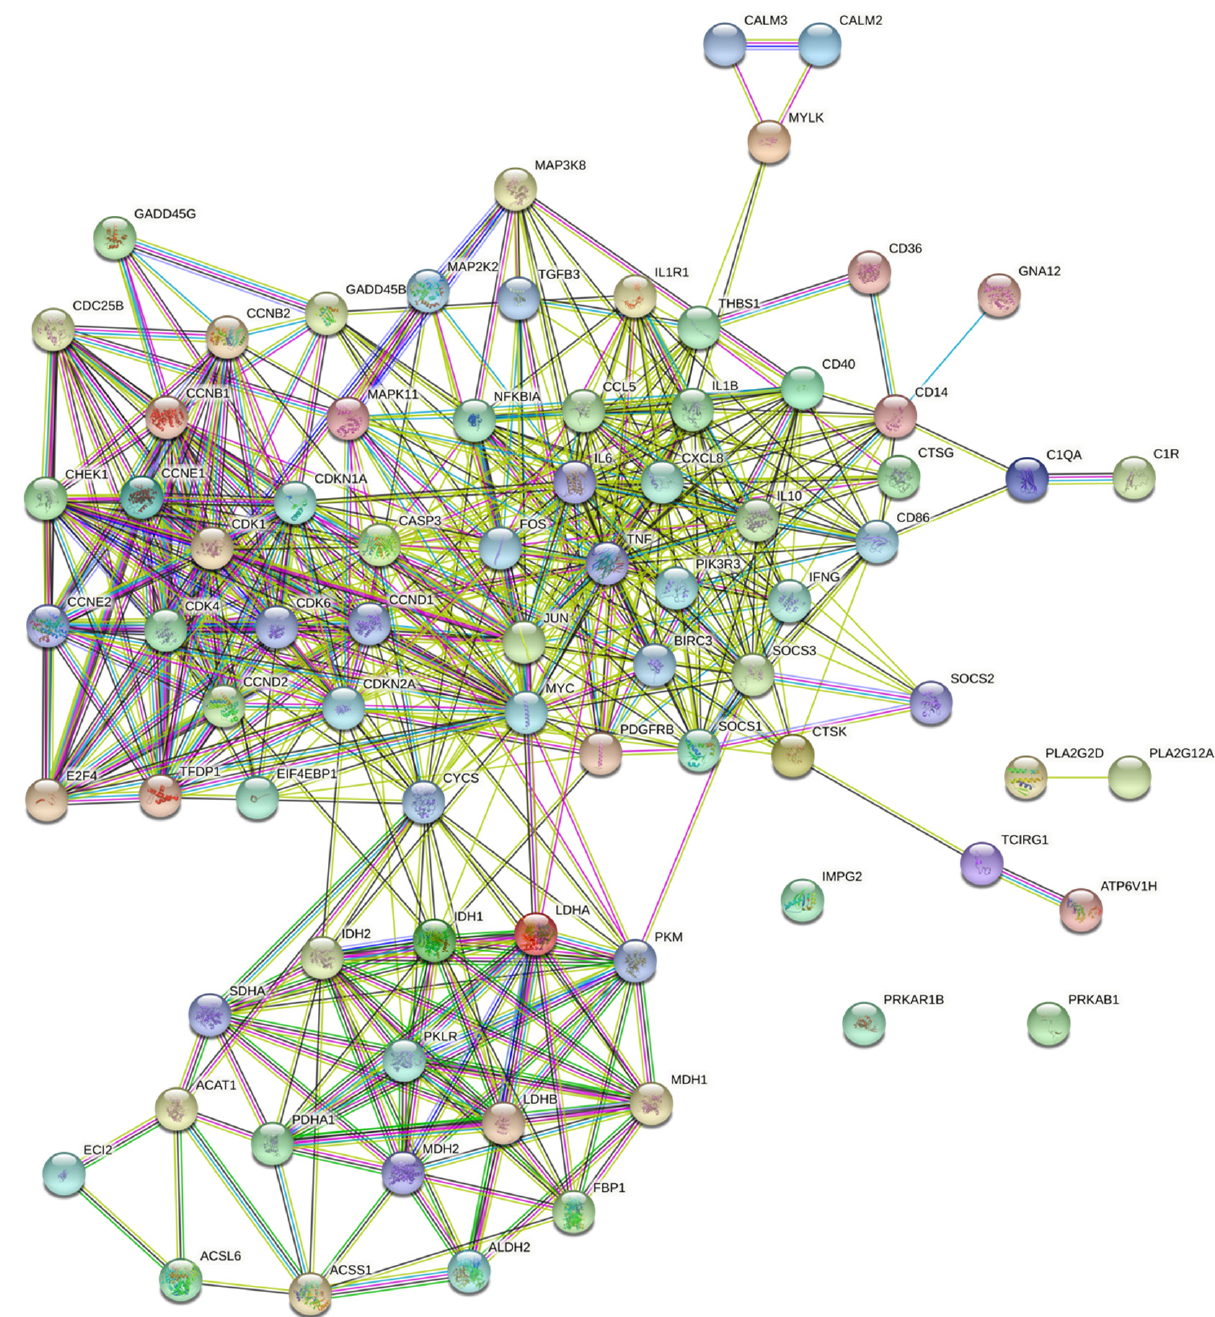
Figure 5. The protein–protein interaction network of 78 proteins encoded by differentially expressed genes involved in 28 signaling pathways.